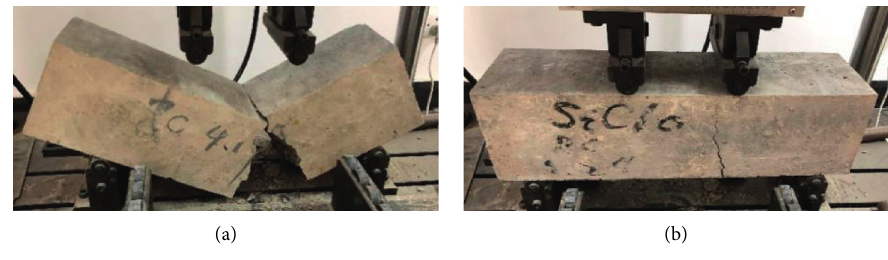
Figure 3: Failure morphology of specimens. Table 3: Fatigue life ( N ) for RC. Specimen no.